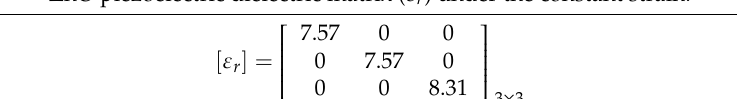
ZnO piezoelectric dielectric matrix ( ε r ) under the constant strain. [ ε r ]